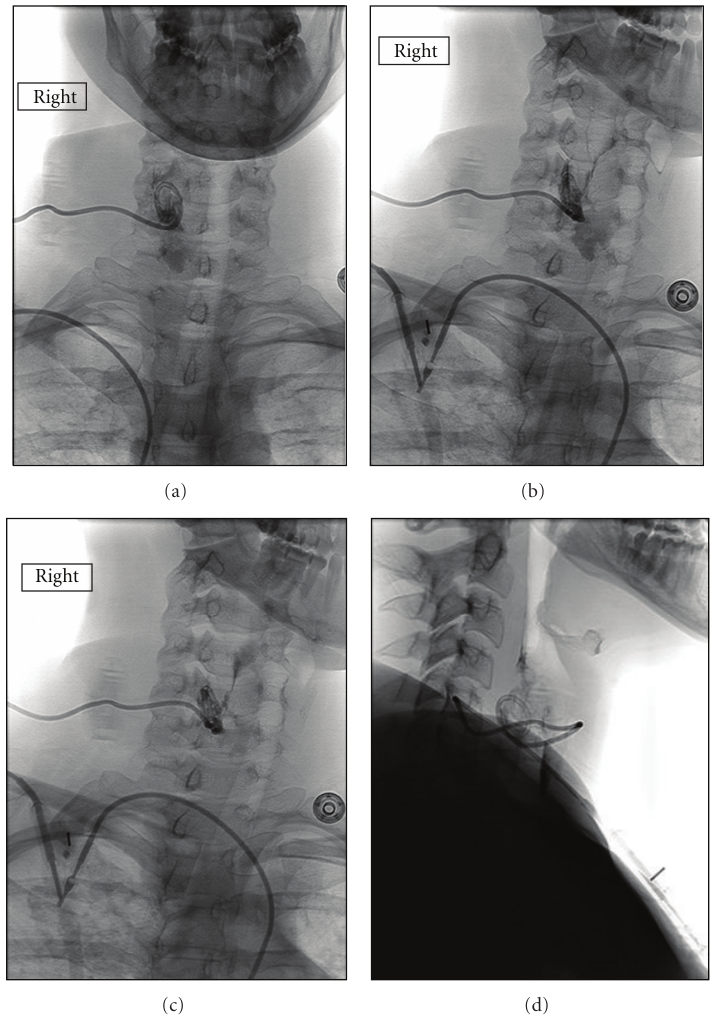
Figure 1: Fluoroscopic sinogram of pigtail catheter drain in the right lateral neck. (a) Anteroposterior view depicting pigtail catheter placed in the right cervical abscess. (b) Oblique view shows contrast exiting catheter and flowing into a fistulous tract leading to (c) the apex of the right pyriform sinus. (d) Lateral view.